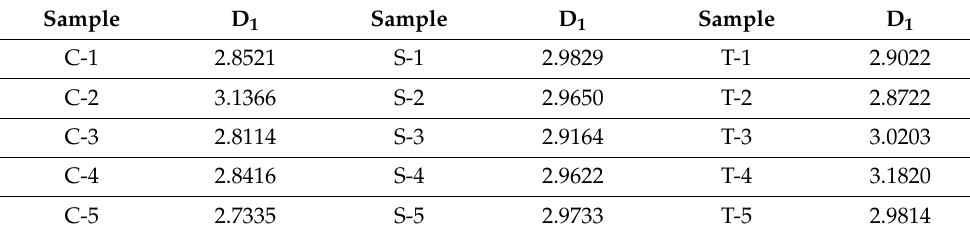
Table 2. The fractal dimension of seepage pores of Munger sponge model.